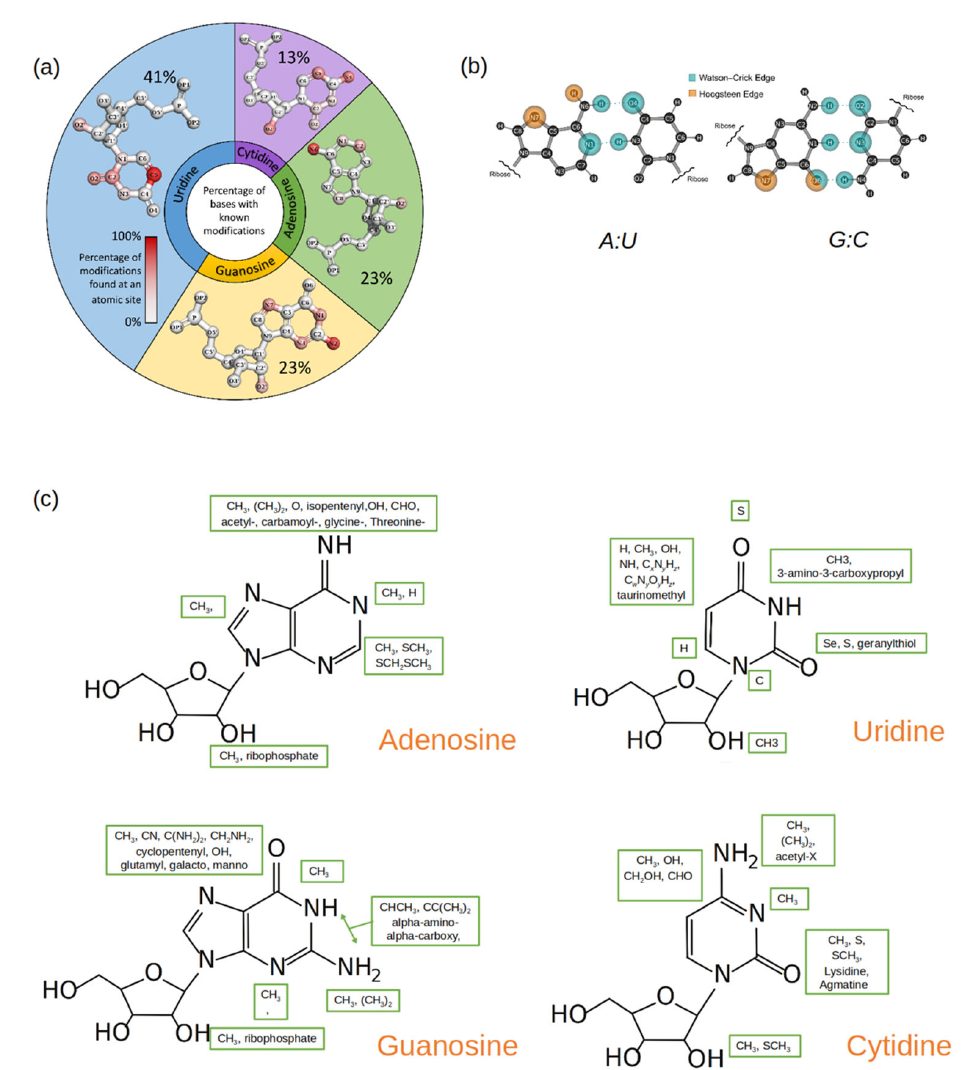
Figure 2. ( a ) A pie plot where each section represents a canonical nucleotide (A, C, G, U) and the size of each section reflects the percentage of the naturally occurring RNA modifications that originate from that canonical nucleotide. Within each pie section, the structure of the canonical nucleotide is displayed, and the atom positions are colored by gradient, which is based upon how frequently that position is modified. ( b ) Standard A: U and G: C base pairs with the Watson–Crick (blue) and the Hoogstein (orange) base pairing edges highlighted. ( c ) Common functional groups (enclosed in green boxes) that occur at different atomic sites in modified nucleotides. The structure of the parent nucleotide is used as a reference.